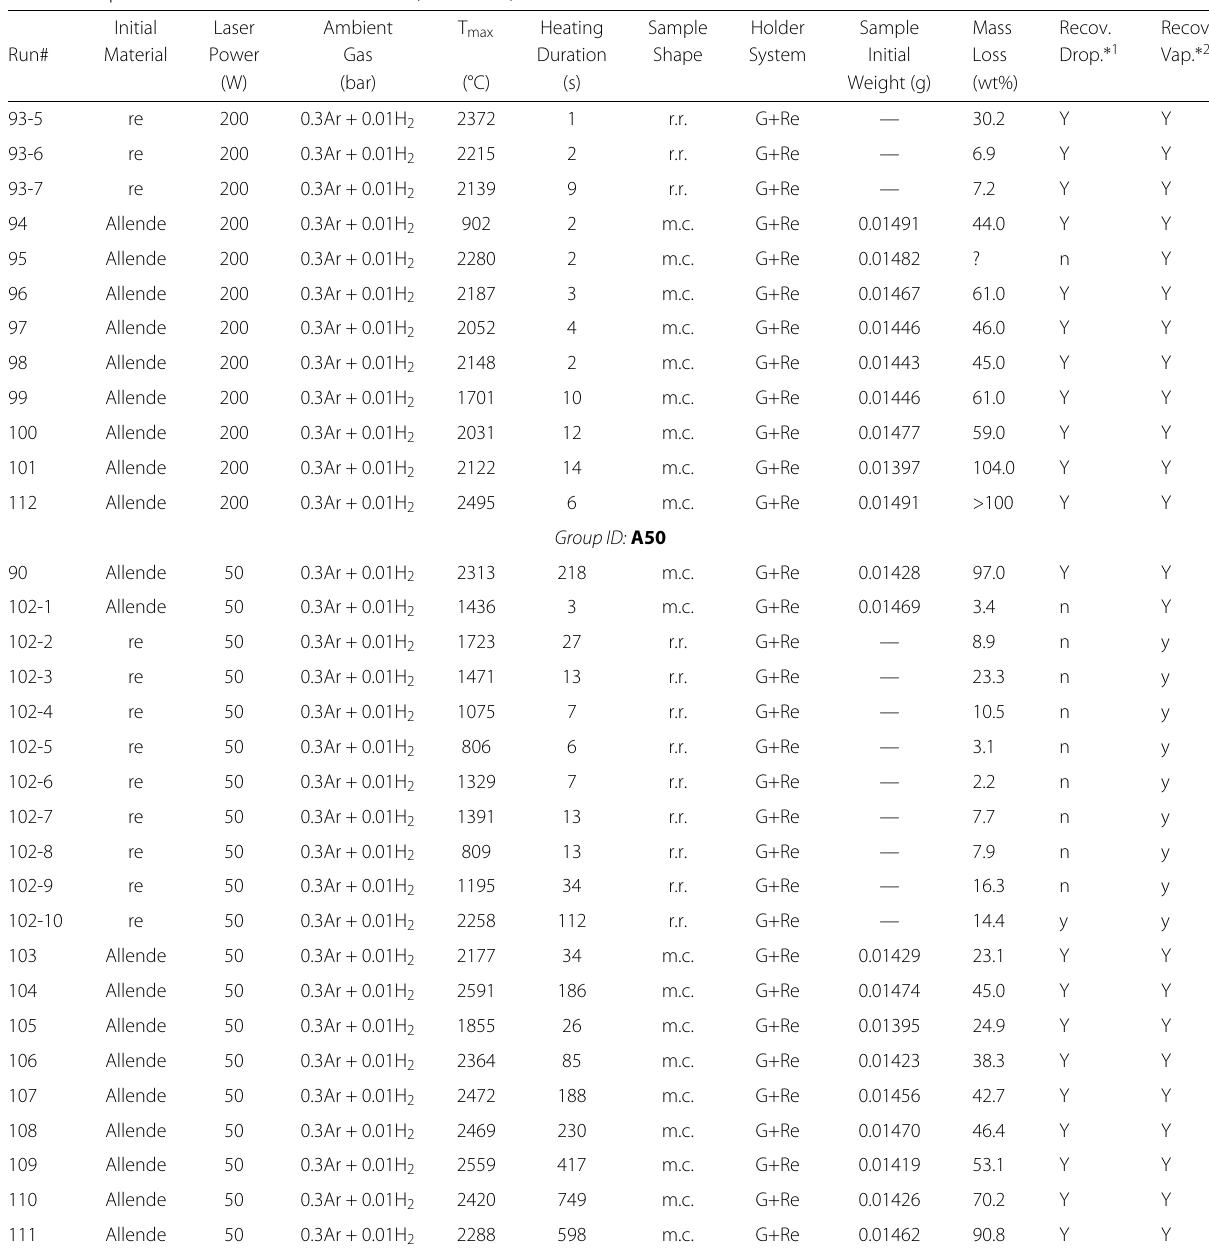
Table 2 Experimental conditions and results ( Continued